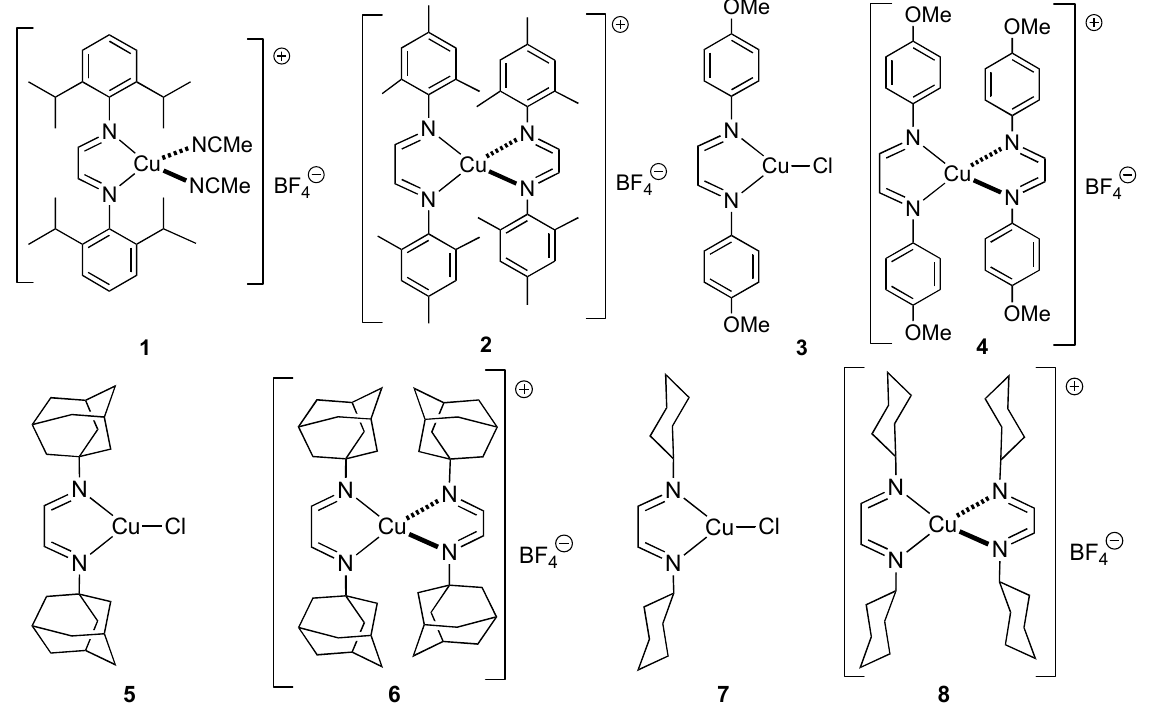
Figure 2. Copper(I) catalysts used in this